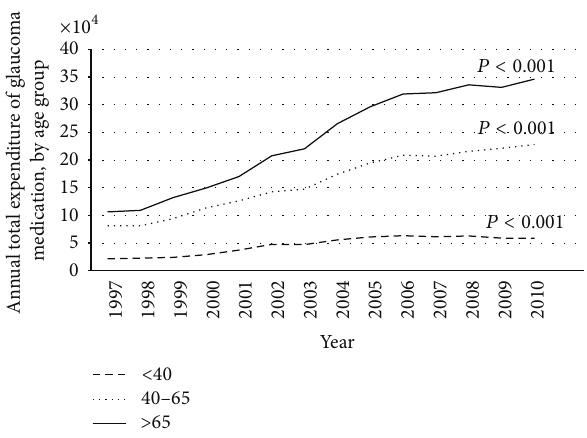
Figure 1: Plot of annual total expenditure of glaucoma medication, by age